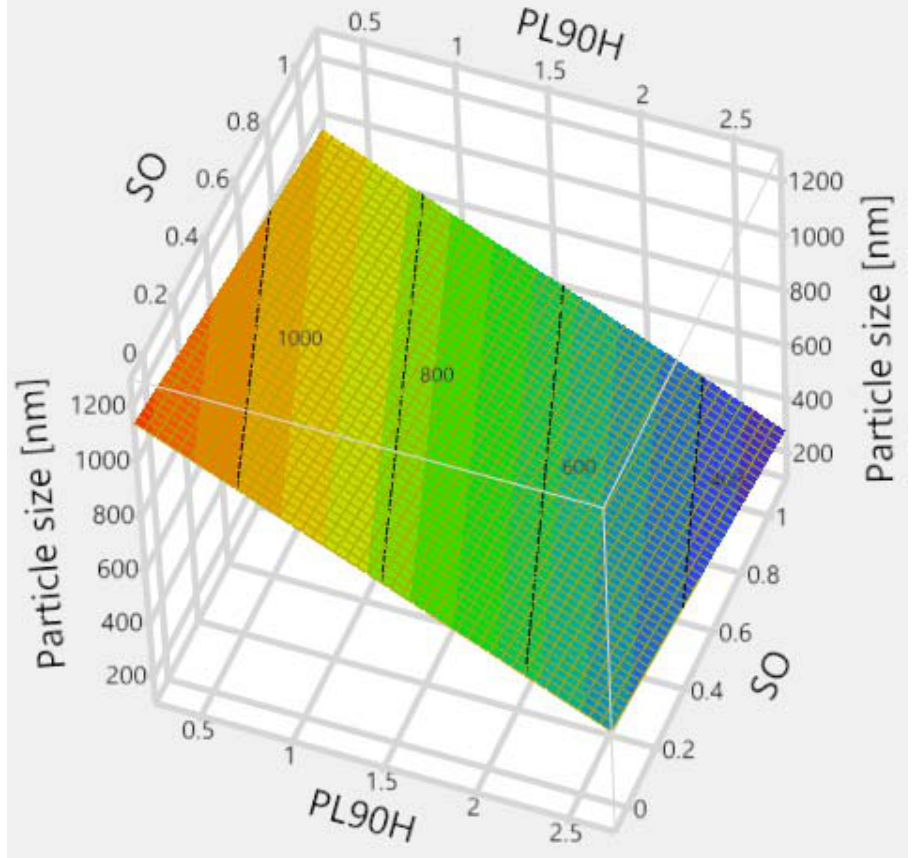
Figure 5. Effect of independent variables on particle size presented in 3D response surface. Figure 5. E ff ect of independent variables on particle size presented in 3D response